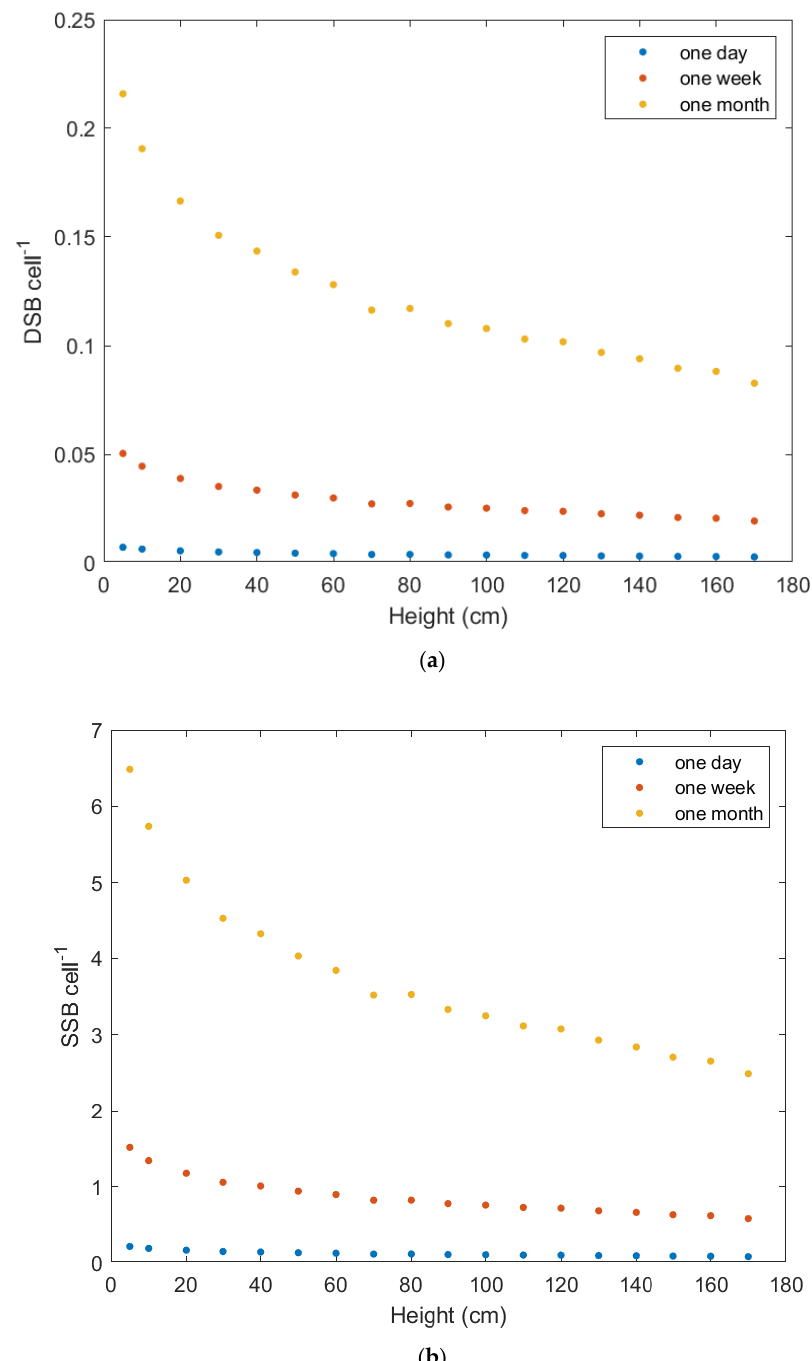
Figure 5. Estimation of the number of ( a ) DSBs and ( b ) SSBs per cell, formed by dose induced by a 137 Cs ionizing radiation of surface activity 3700 kBq·m − 2 for an exposure time of a day, one week and a month, using MCDS simulations.